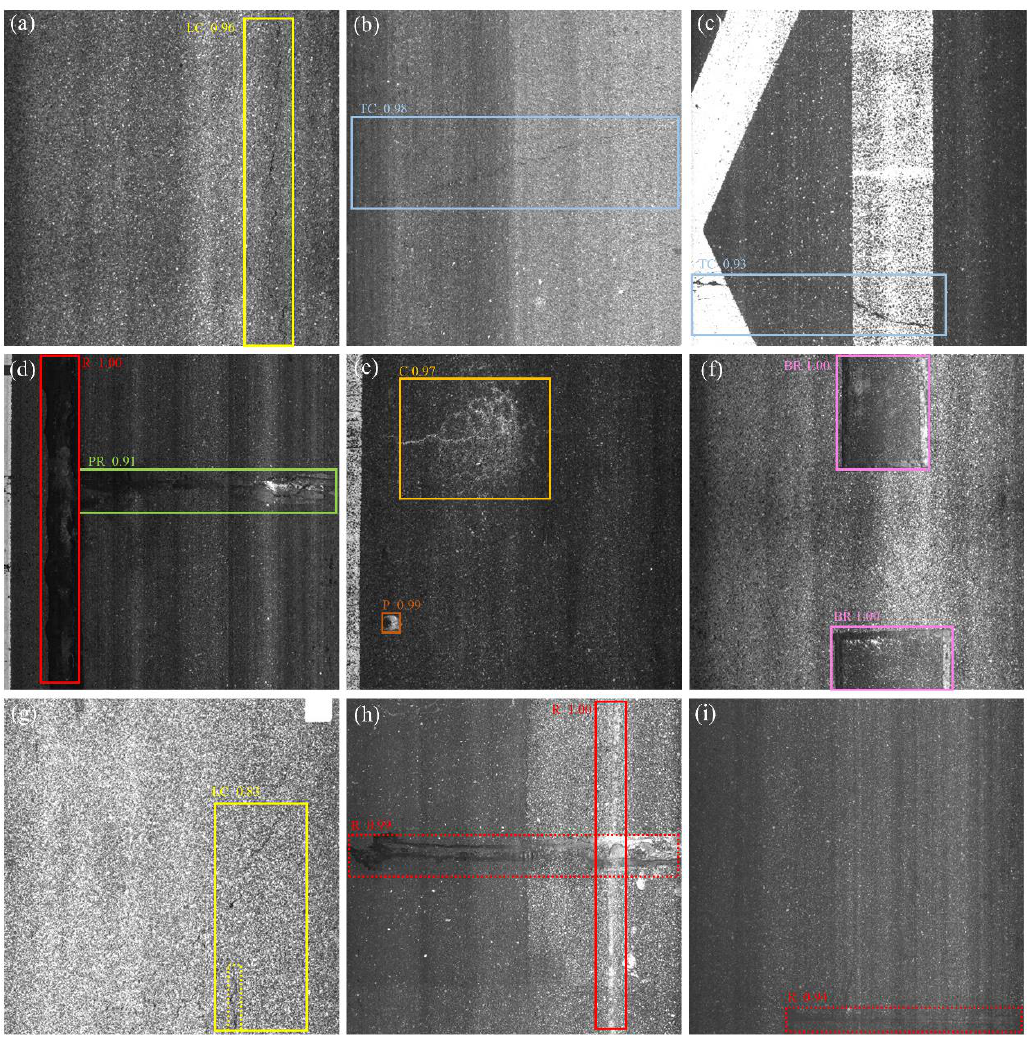
Figure 9. Results of CrdNet HL2019 test set. ( a – f ) in first two rows are true positive results of proposed method. ( g – i ) in last row represents typical failure cases of CrdNet; dashed box with text on top represents false positive, and dashed box without text represents false negative.